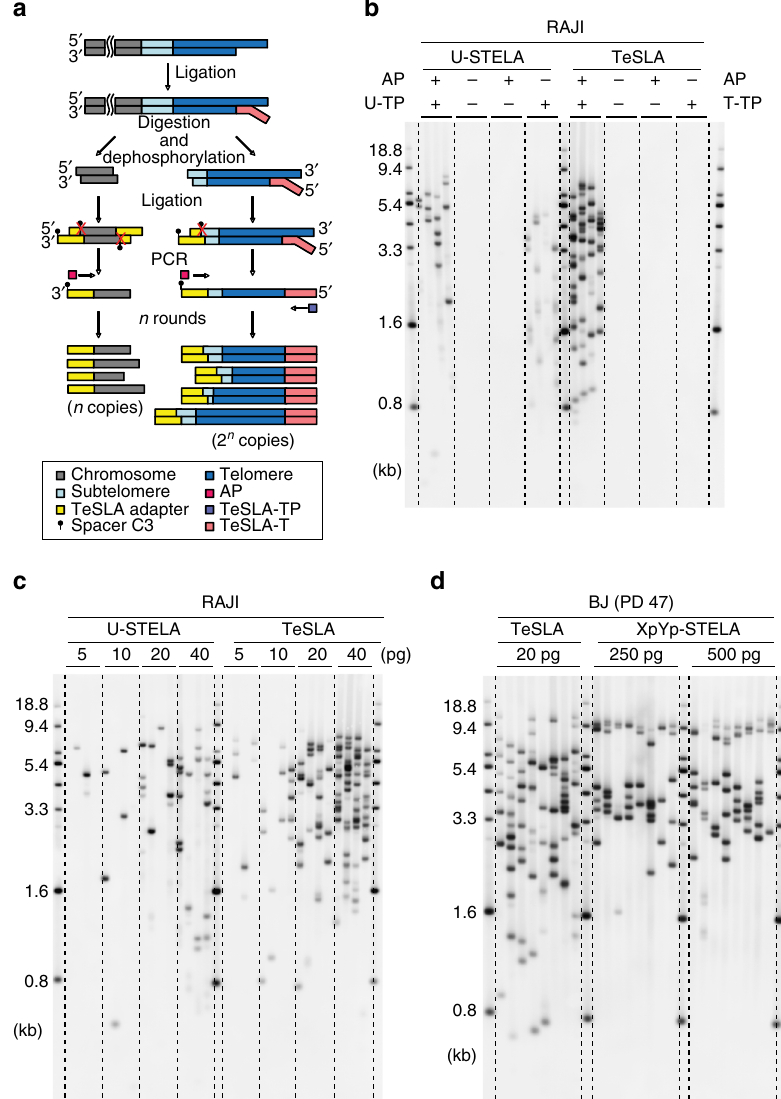
Fig. 1 Overview of Telomere Shortest Length Assay (TeSLA) and comparison to Universal STELA (U-STELA) and XpYp STELA. a Schematic of overall TeSLA methods. Extracted genomic DNA is ligated with TeSLA-Ts (each TeSLA-T contains seven nucleotides of telomeric C-rich repeats at the 3 ′ end) at the overhangs of telomeres and then digested with a restriction enzyme panel. Digested DNA is subsequently ligated with doubled-stranded TeSLA adapters at the proximal end of telomeres and genomic DNA fragments. After adapter ligation, PCR is performed to amplify ligated telomeric DNA. b About 40 pg of DNA from RAJI cells was used in each U-STELA and TeSLA reaction to test speci fi city of primers for telomere ampli fi cation and was tested as indicated (AP, adapter primer; U-TP, U-STELA teltail primer; T-TP, TeSLA-TP). c The sensitivity of U-STELA and TeSLA was compared by serial dilution of DNA from RAJI cells from 5 to 40 pg. d Using TeSLA (20 pg DNA for each reaction) and XpYp STELA (250 and 500 pg of DNA for each reaction) to detect TL in BJ